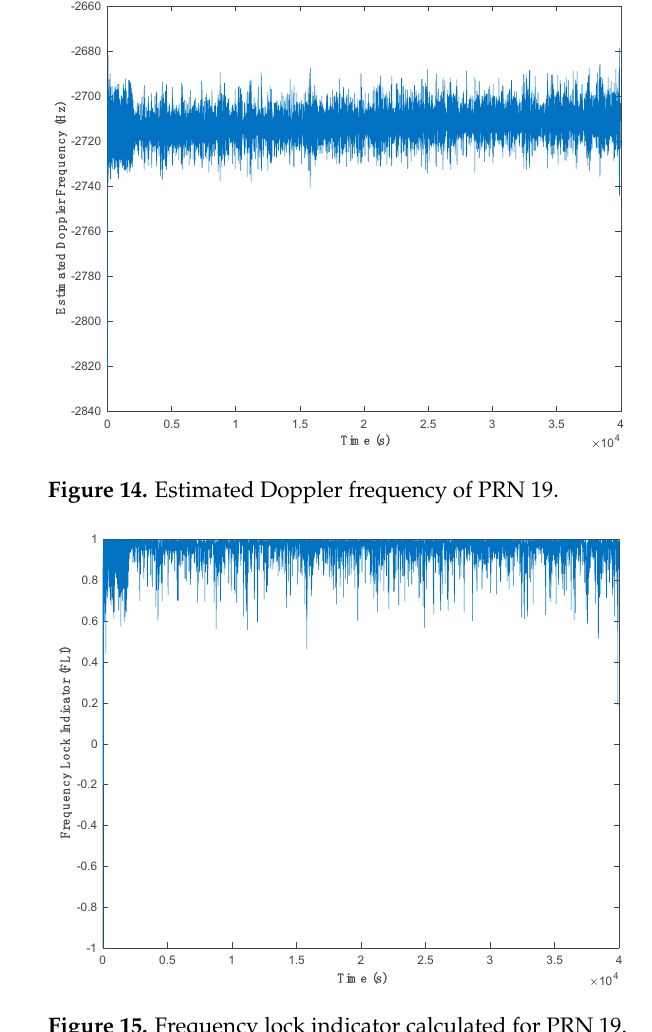
Figure 15. Frequency lock indicator calculated for PRN 19.